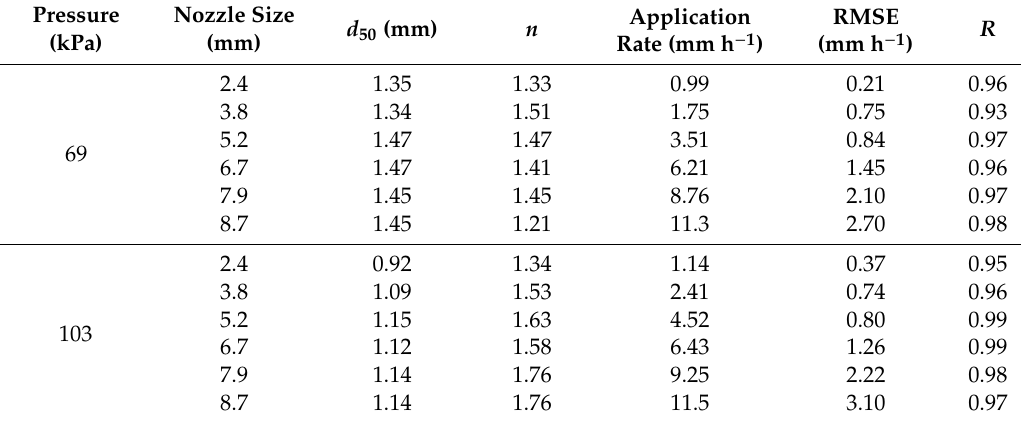
Table 4. Optimal parameters of Weibull drop size distribution model for both operating pressures and nozzle sizes.